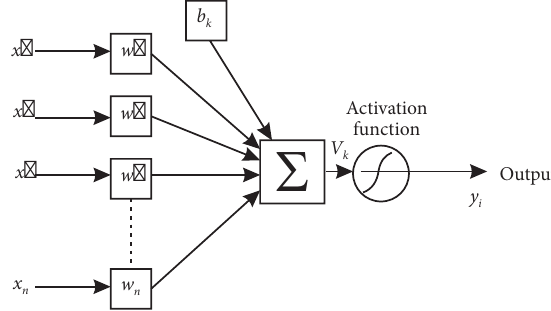
Figure 11. Architecture of an artificial